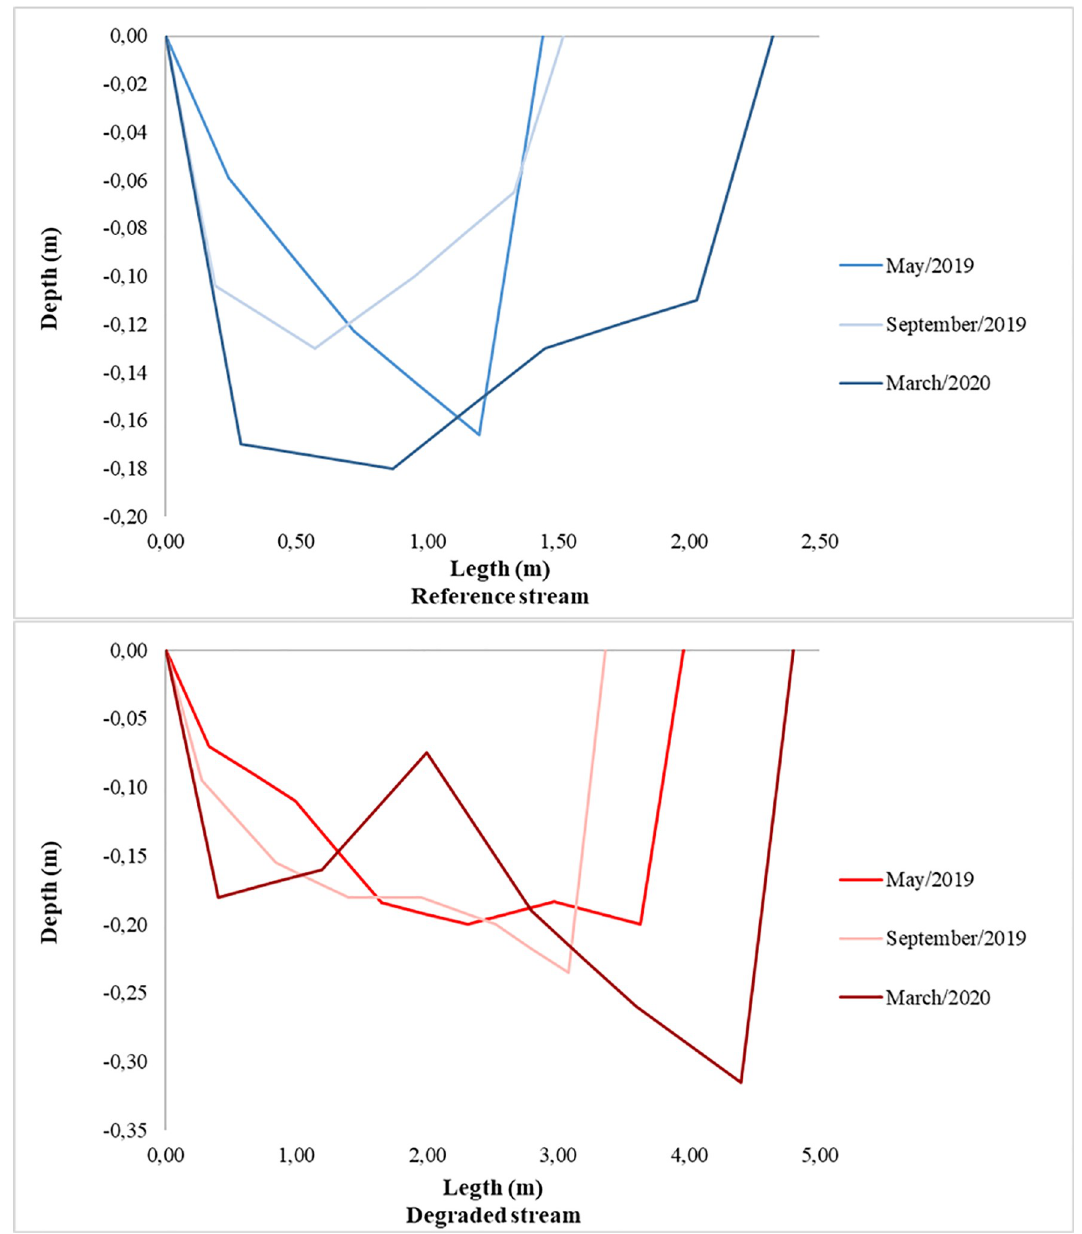
Fig 4. Profiles of the cross-sections further downstream of the reference stream (RS) and the degraded stream (DS) in Catal ã o, GO, Brazil. The profiles correspond to the beginning of the dry season (May/2019), end of the dry season (September/2019) and end of the subsequent rainy season (March/2020) on the same sites in the RS e